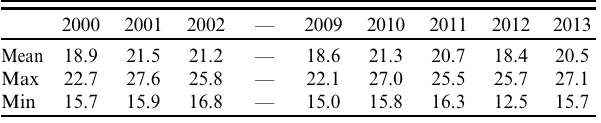
Table 4 . July temperatures (degrees Celsius) of Juday Creek at the Warren Golf Course. Temperatures were recorded hourly on a continuous basis from August 2008 through September 2013, and in 2000–2002 during the month of July.